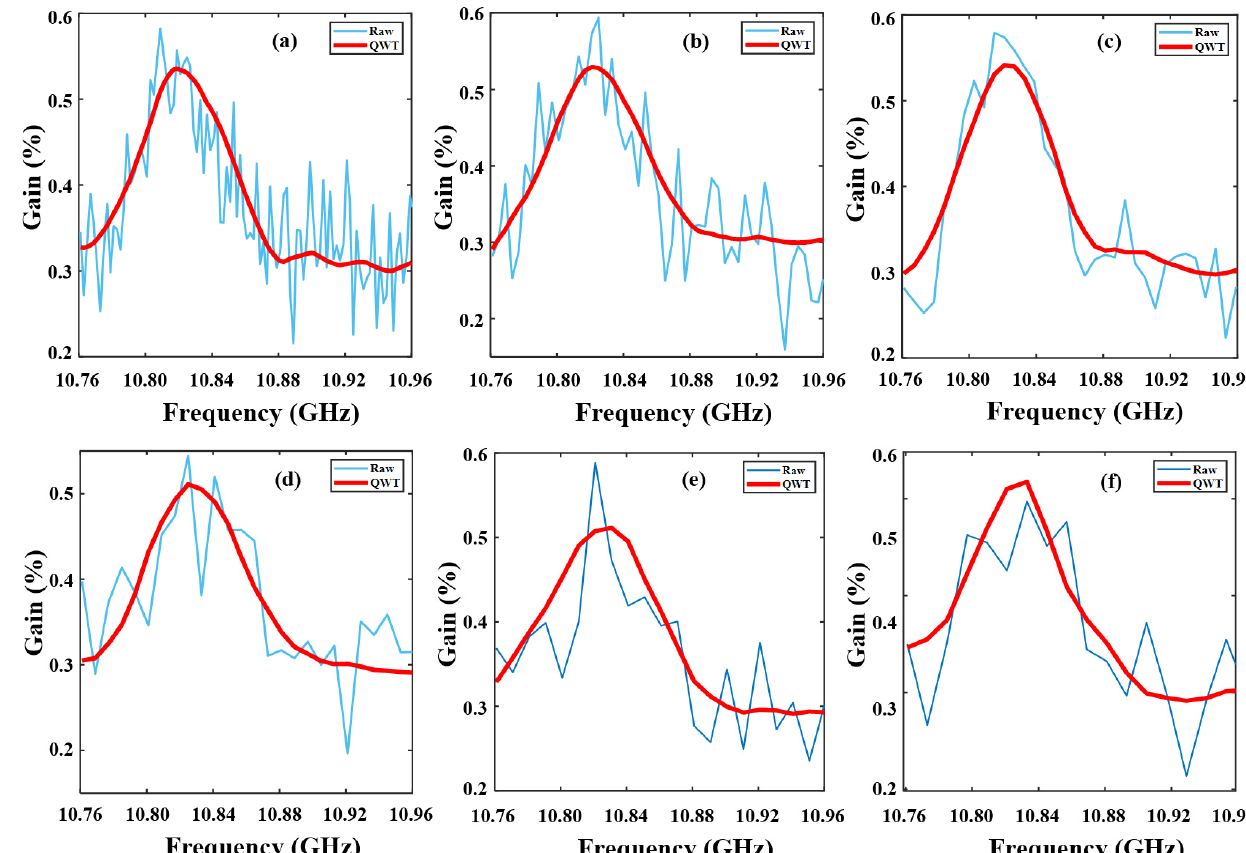
Figure 7. GS curves with different frequency intervals ( a ) 2M, ( b ) 4M, ( c ) 6M, ( d ) 8M ( e ) 10M and ( f ) 12M.